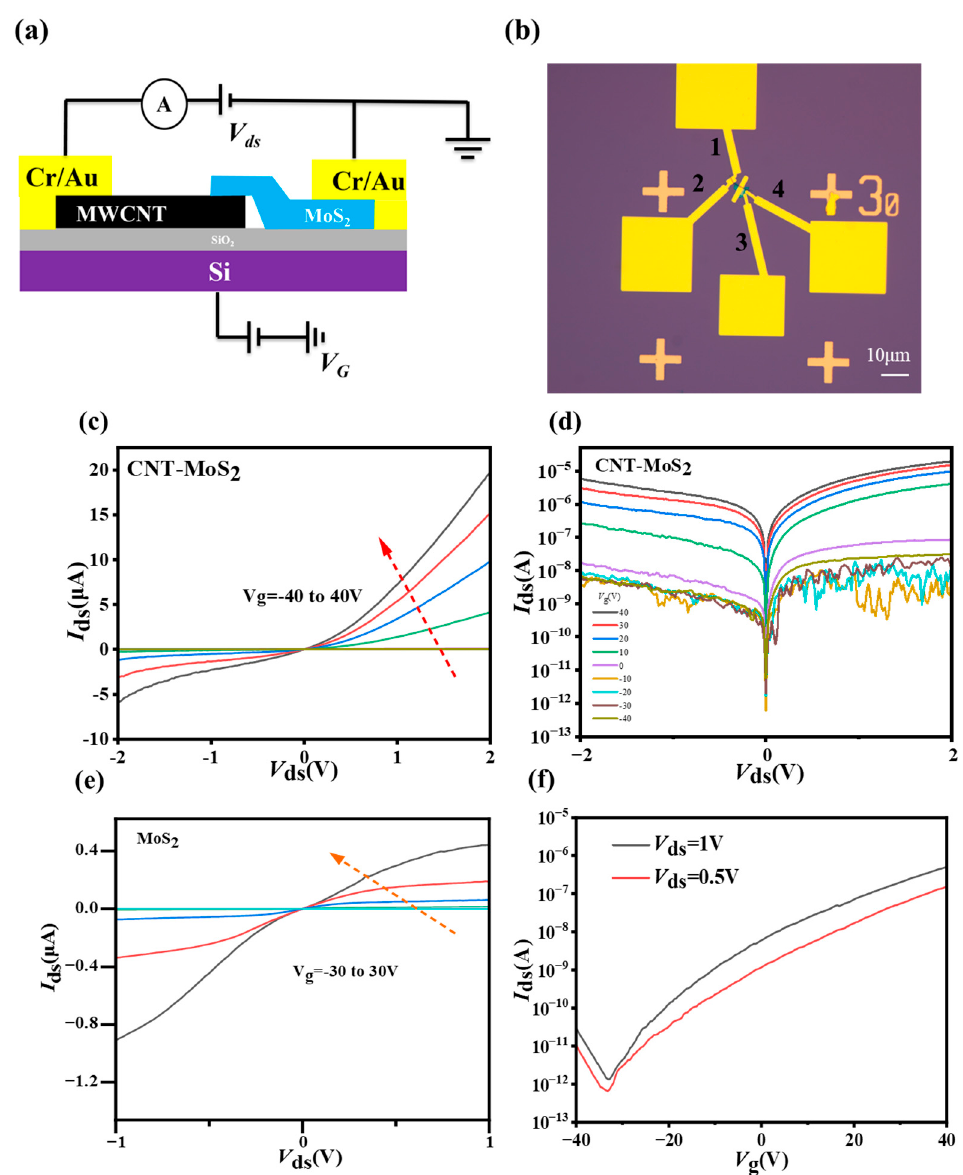
Figure 5. ( a ) Schematic diagram of a representative device; ( b ) optical image of the device with electrodes 1 and 2 in contact with CNT and electrodes 3 and 4 in contact with MoS 2 ; ( c ) transfer characteristics of the heterostructure devices at different gate voltages; ( d ) corresponding logarithmic plots of the transfer curves; ( e ) transfer characteristics of MoS 2 device at different gate voltages; ( f ) transfer curves of MoS 2 at 0.5 V and 1 V bias voltage, respectively. Notes: (( c , e ) the missing curves overlap at the 0 axis).